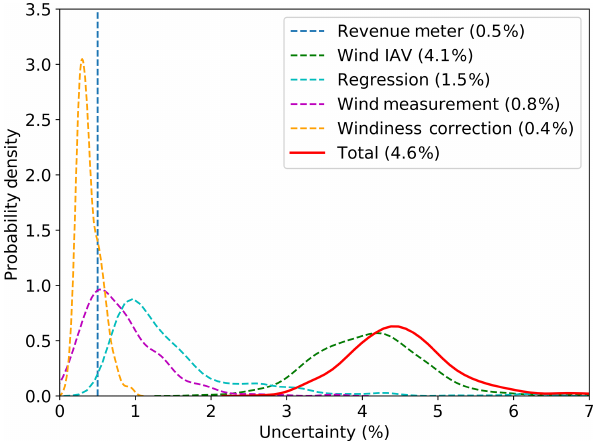
Figure 5. Operational-based AEP uncertainty distributions across projects for the different uncertainty components; mean values across projects are shown in the legend. Uncertainty values are quantified as the percent coefficient of variation of the long-term operational AEP